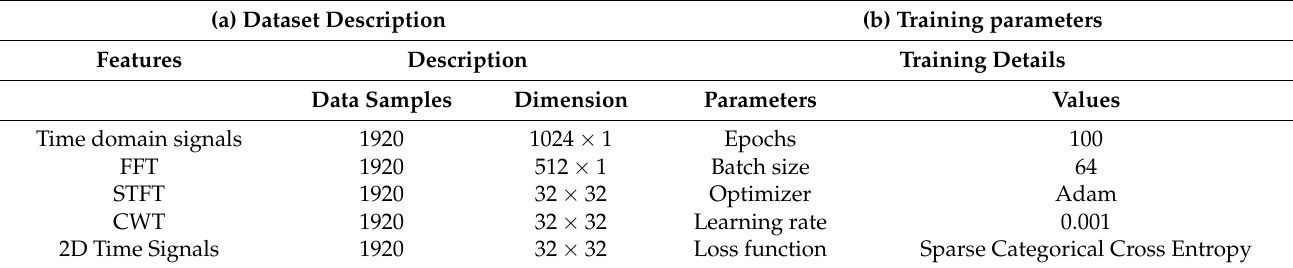
Table 4. Dataset and model training